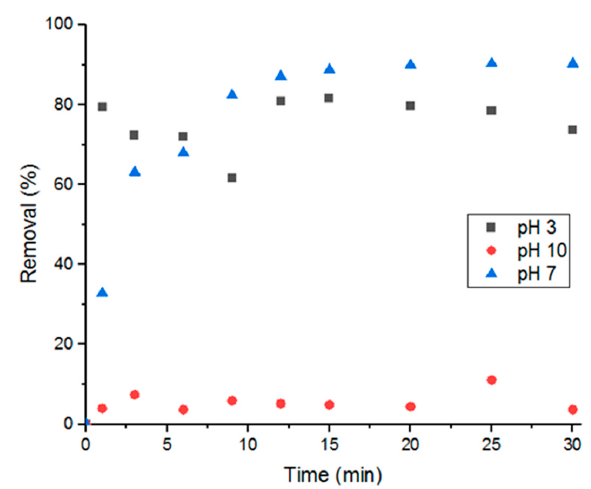
ff ect of solution pH on percent Figure 9. Effect of solution pH on percent removal. Figure 9. E